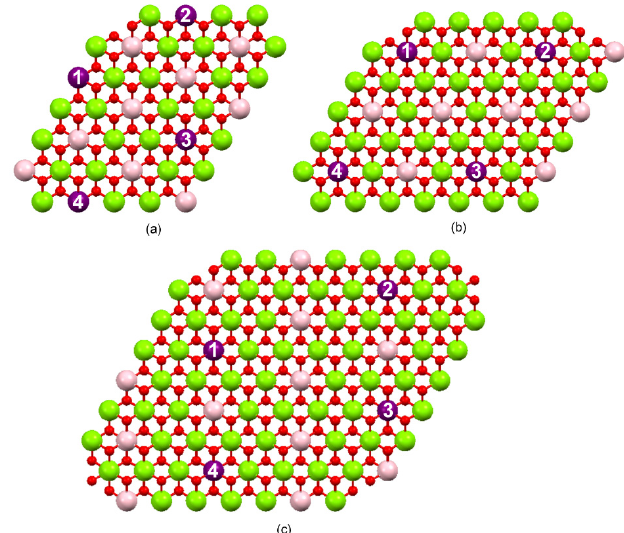
Figure 9. Schematic representation of the structure of the LDH prepared at Mn 2+ /M 3+ molar ratio of: ( a ) 2:1; ( b ) 3:1; ( c ) 4:1. The pink and purple balls represent the species M 3+ , the green balls represent the